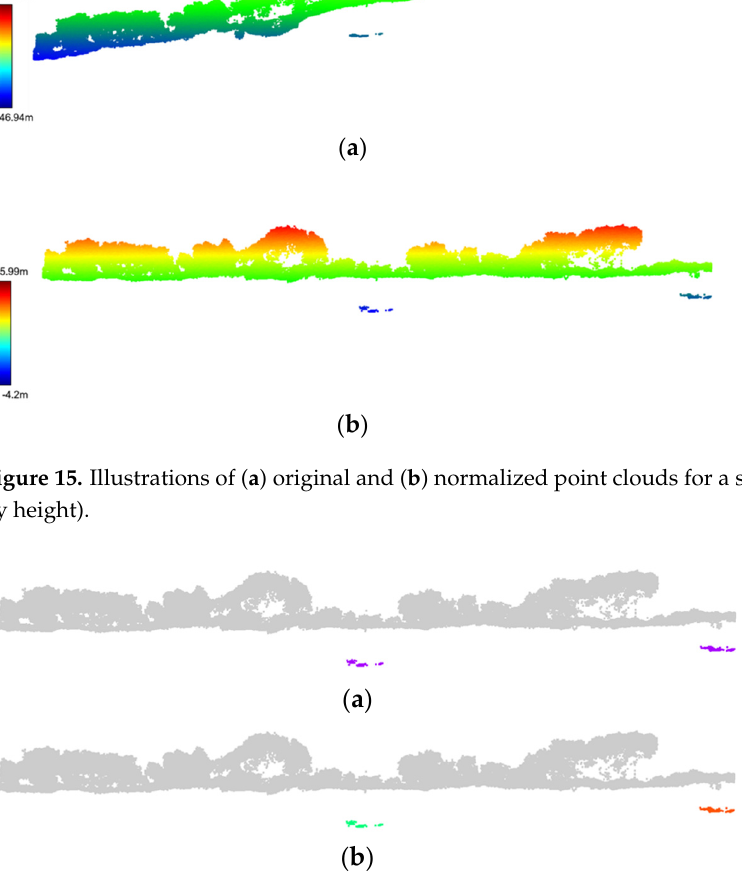
Figure 16. Illustrations of ( a ) derived below-surface points (in purple) and ( b ) identified two clusters (in green and orange) representing underground structures, other points are colored in gray.